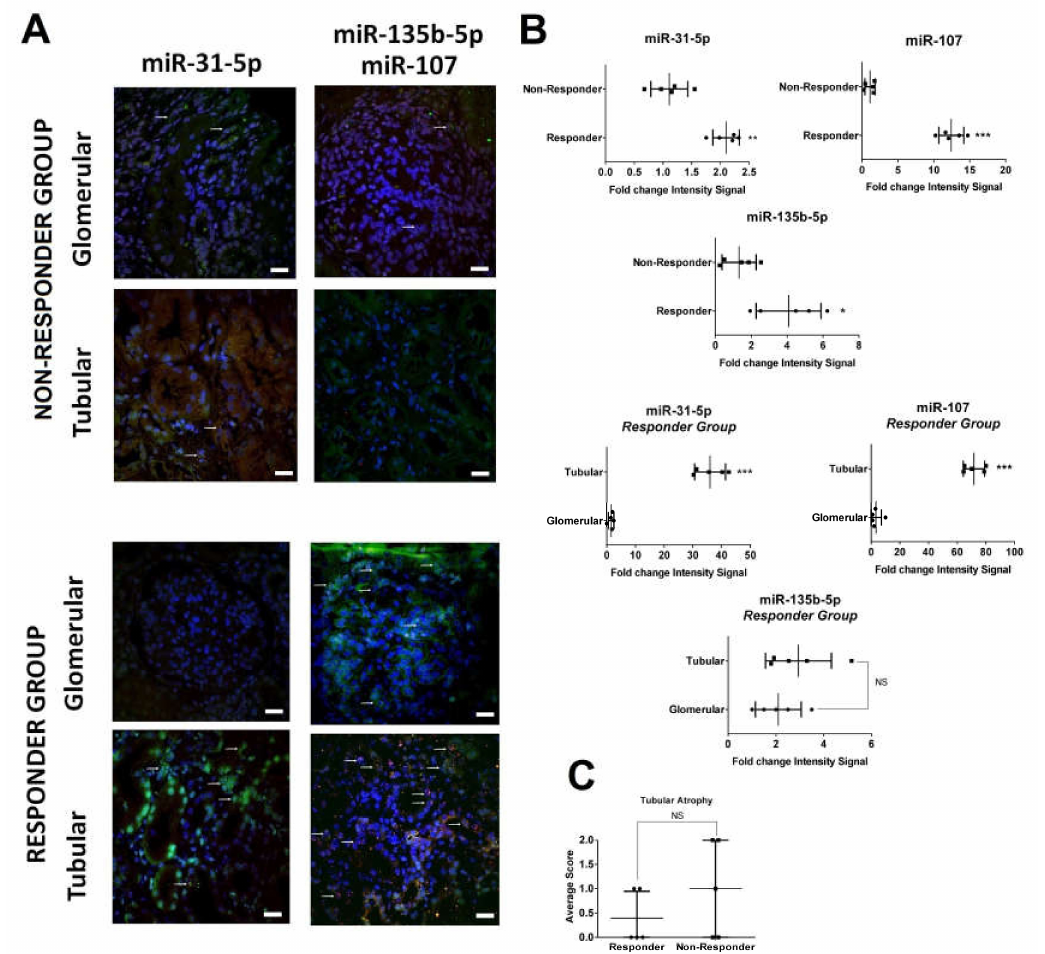
Figure 3. In situ hybridization of miR-31-5p, miR-135b-5p, and miR-107 in LN renal biopsies. ( A ) At flare time, renal tissue from lupus nephritis was analyzed to identify miR-31-5p, miR-135b-5p (both in green), and miR-107 (red). Significant di ff erences were found between the responder and non-responder groups. ( B ) Tubular localization was found for miR-31 and miR-107 in the responder group. ( C ) No di ff erences in tubular atrophy were observed between the responder and non-responder groups in histology analysis. Scale bar = 20 µ m. White arrows marked positive cells. p -Values were obtained using Student’s t -test. NS: not significant, * p < 0.05; ** p < 0.005; *** p <